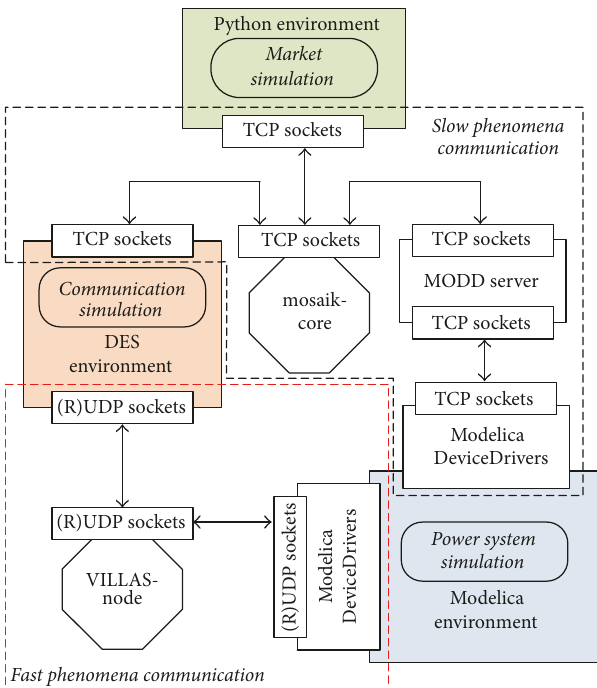
Figure 6: Scheme of runtime interaction between cosimulation components.